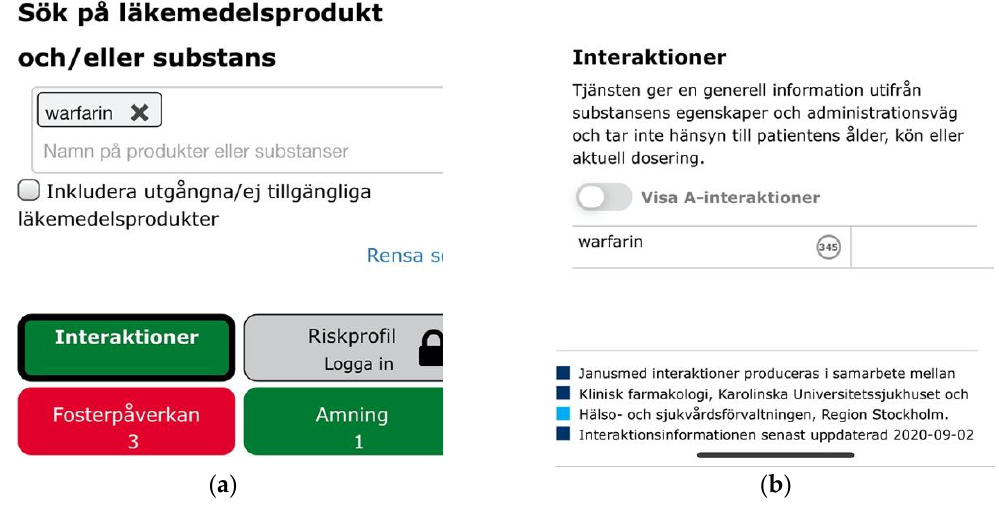
Figure 16. ( a ) A green indicator for interaction analysis of warfarin indicating its safety; ( b ) Visually de-emphasized and unlabeled indicator for 347 drug interactions pertaining to warfarin.